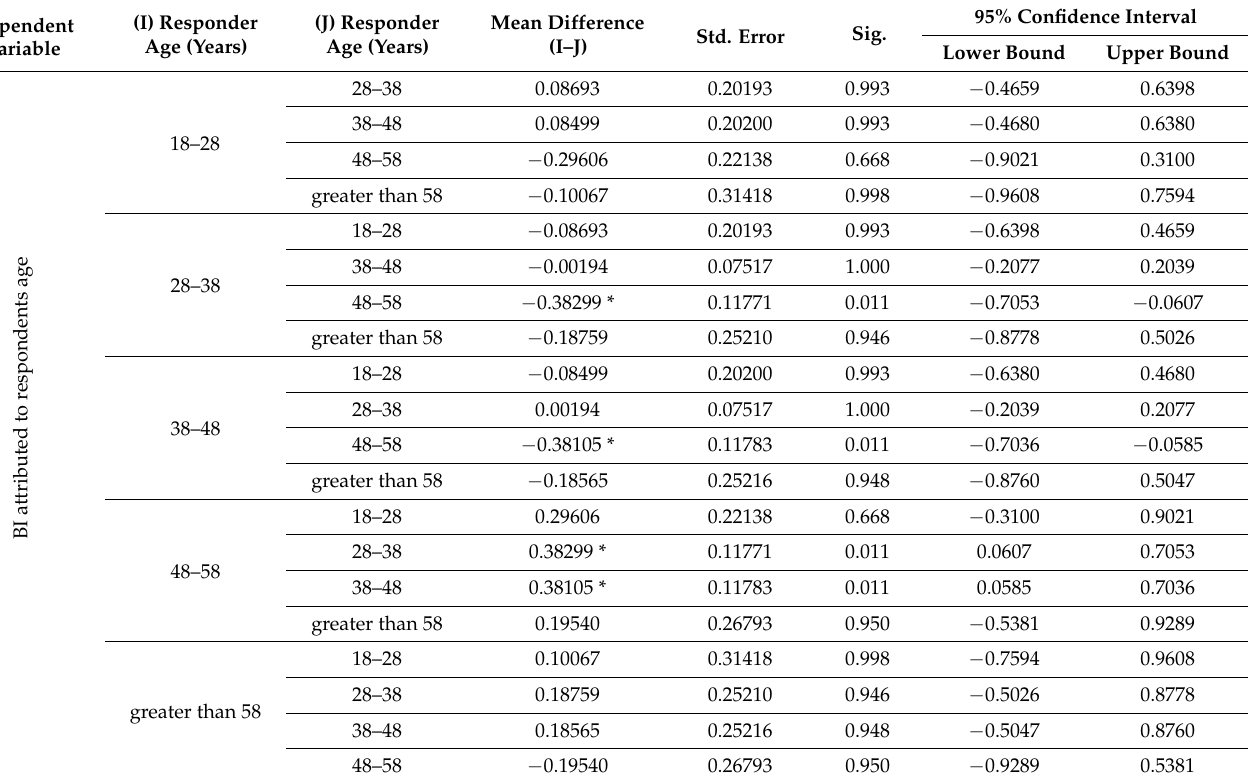
Table 14. Multiple comparisons analysis of the BI attributed to respondents’ age using Tukey